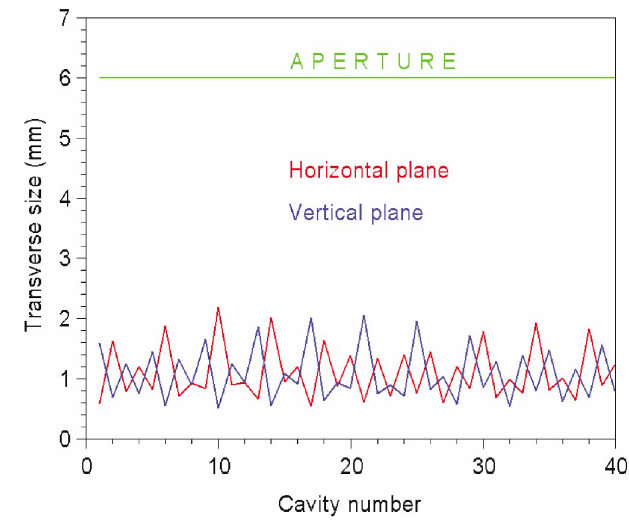
FIG. 22. (Color) rms emittance versus cavity number for zero current. FIG. 23. (Color) rms transverse sizes vs cavity